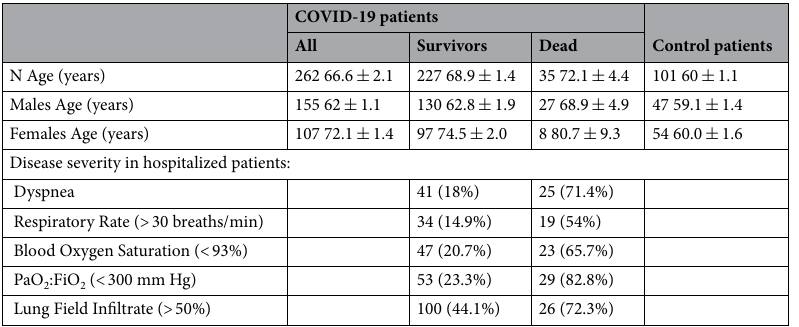
Table 1. Characteristics of SARS-CoV-2 patients and